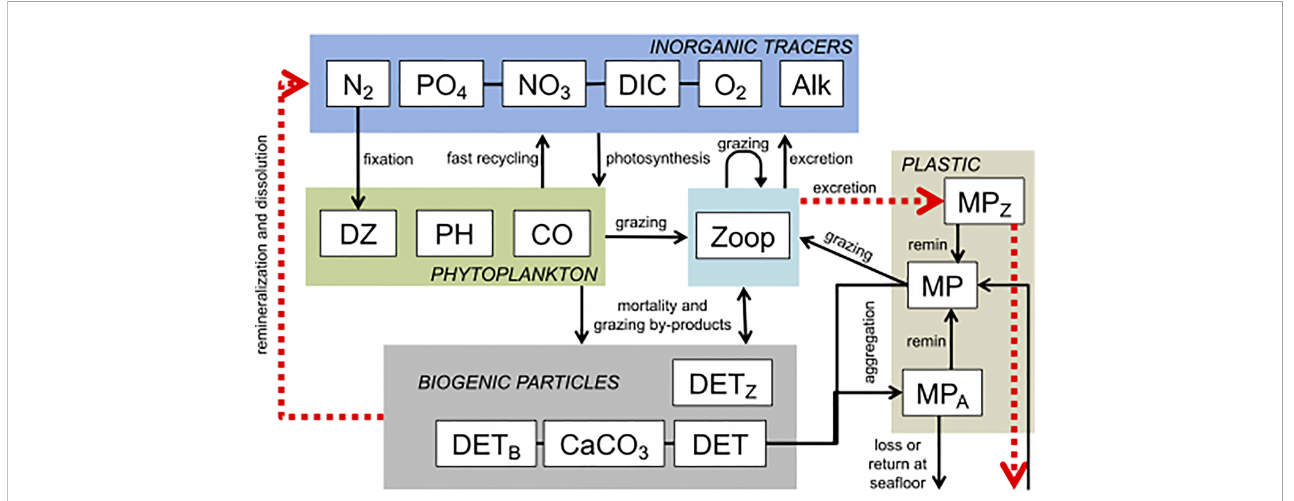
FIGURE 1 Model schematic modi fi ed from Kvale et al. (2020b). State variables are shown in rectangles and are categorized in labelled, coloured rectangles. Black lines show mass fl ux (in nitrogen units for the biological variables) or particle fl uxes (microplastic). Marine snow is produced as a fi xed fraction of the free (unattached) organic detritus (DET) pool. Microplastic (MP) aggregates with this marine snow, entering the MP A (marine snow entrained MP) pool. MP A sinks at the aggregate rate, with a fraction reaching the sea fl oor considered to be lost from the ocean. Detrital remineralization releases the MP A from marine snow aggregates at the rate of detrital remineralization. MP is also grazed by zooplankton (Zoop) and excreted into a pellet-bound MP Z pool. Pellet-bound MP Z sinks and is released back to the free (unattached) MP pool at the rate of detrital remineralization, but some is also lost at the sea fl oor. In the experiments reported here, faecal pellet-bound detritus (DETz) as well as pellet-bound microplastic sinking speed is determined by Eqns. 13. Fluxes impacted by this modi fi cation are shown in red, dashed arrows. Details on the biogeochemical aspects of the model are previously described (Kvale et al.,